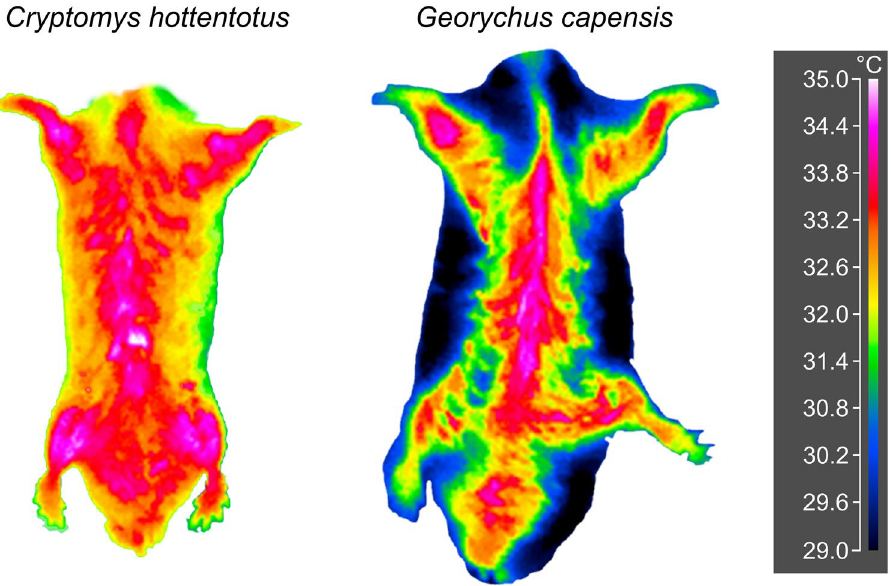
Figure 5. An example of thermogram showing the differences in surface temperature of the venter at 30 °C between the solitary Cape mole-rat G. capensis and the social common mole-rat C. hottentotus . The figure was prepared using the program Inkscape 0.92 (https ://inksc